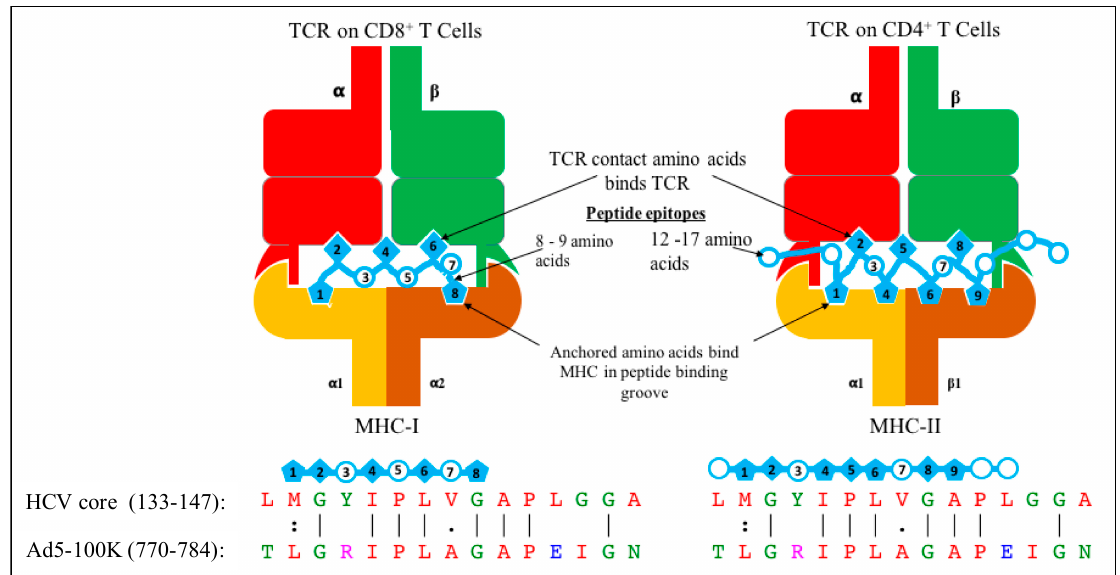
Figure 4. Putative model of CD8 + and CD4 + T cell receptor recognizing heterologous HCV core peptide (133–147) and Ad5 100K protein epitope (770–784) in context of MHC.